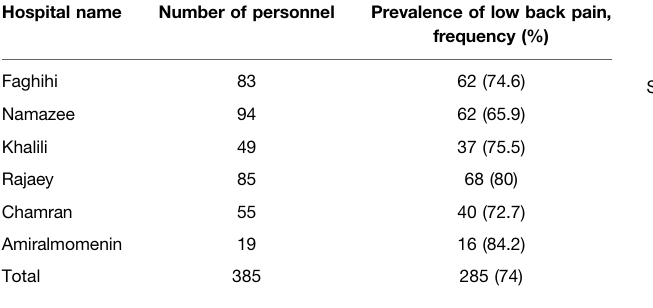
TABLE 2 | Prevalence of LBP in the studied hospitals.